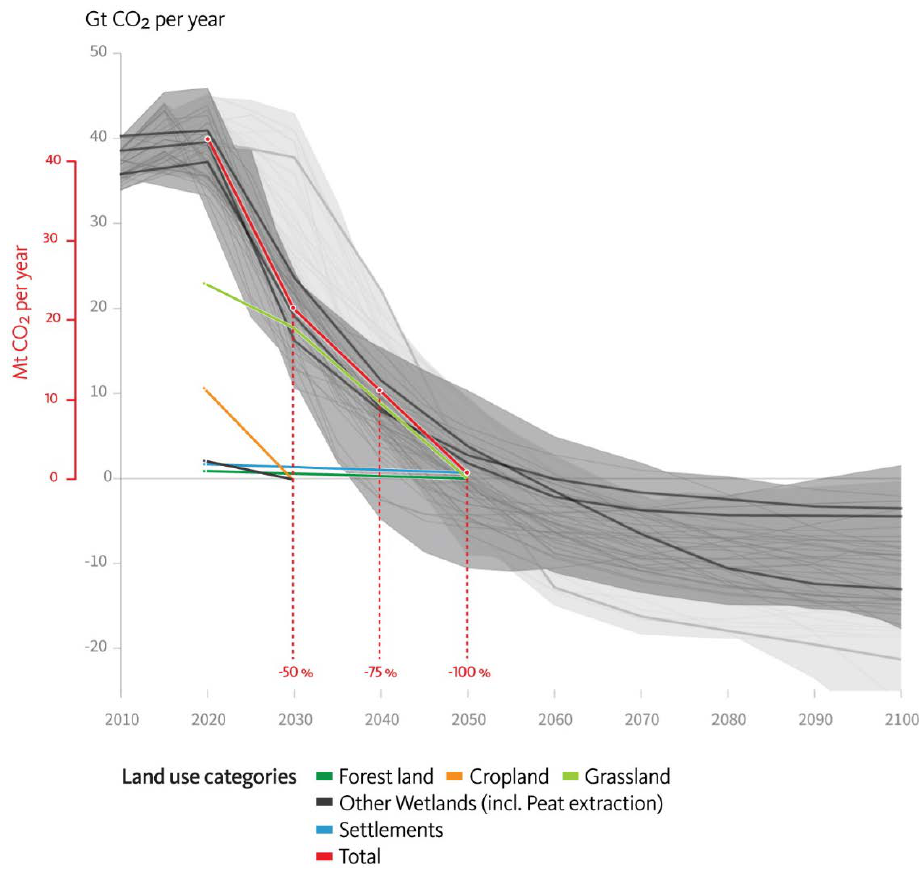
Figure 2. Main graph: Four illustrative global CO 2 emission trajectories with net zero in 2050 (in Gt yr -1 ; IPCC 2018). Inset: CO 2 emission trajectories with net zero in 2050 for different land use categories on organic soils in Germany, pathway 1 (in Mt yr -1 ; this